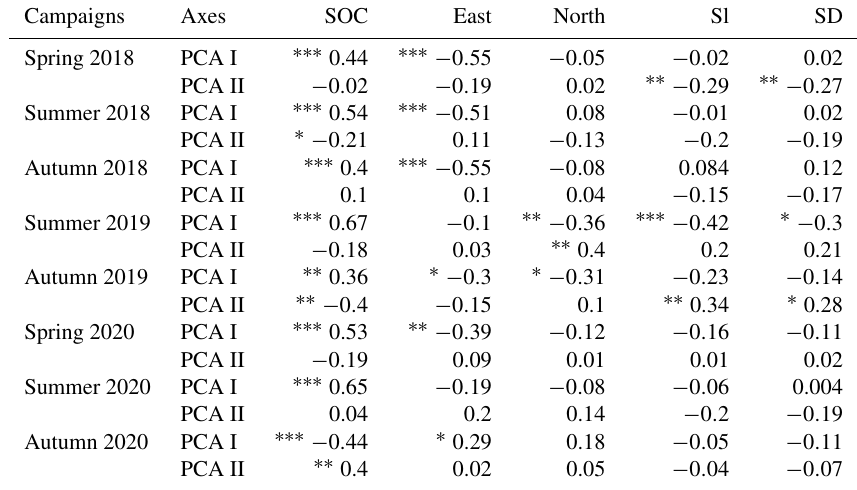
Table 4. Spearman correlation coefficients between PCA scores of Fig. 4, soil organic carbon (SOC) and terrain attributes ( ∗∗∗ : P < 0 . 001, ∗∗ : P < 0 . 01, ∗ : P < 0 .